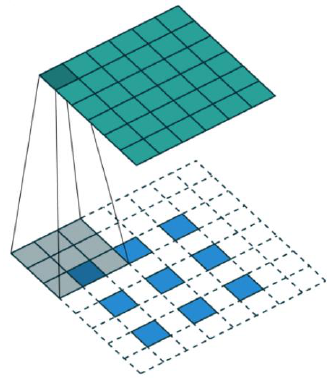
Figure 3. An illustration of deconvolution. It consists of inserting zeros and convolution operation